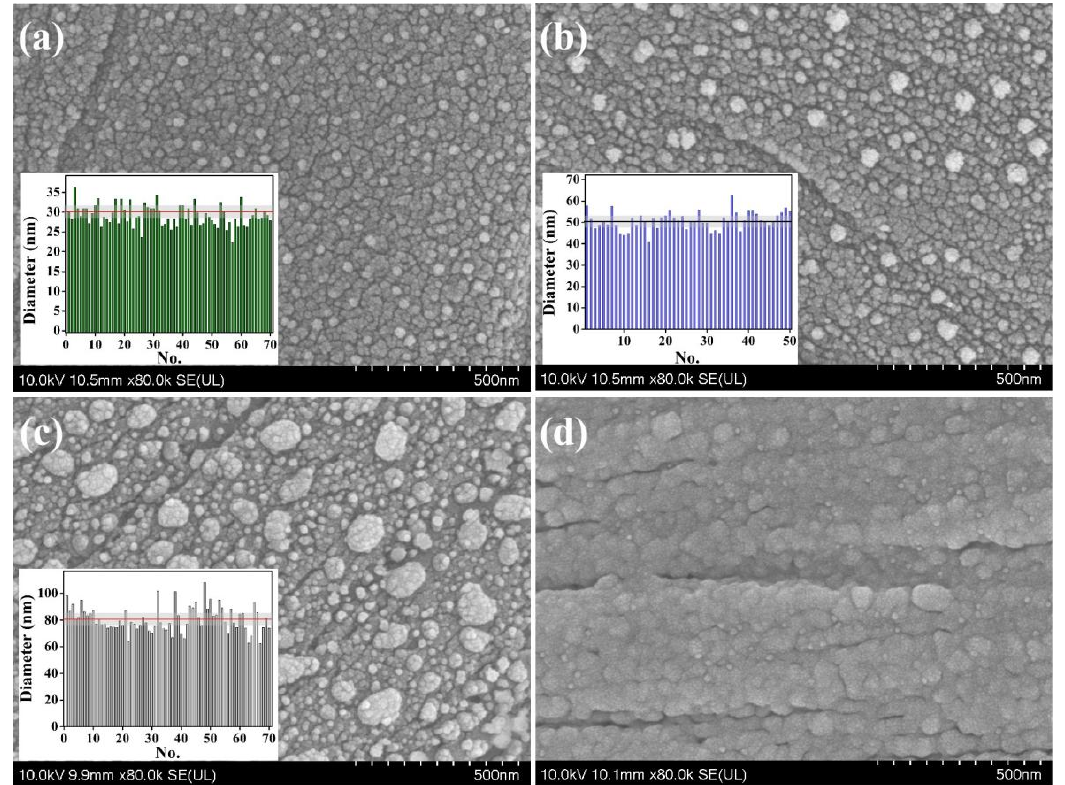
Figure 4. Amplifying FE-SEM images of Ag x -C-fiber substrates prepared with different sputtering times: ( a ) Ag 15 -C-fiber substrate; ( b ) Ag 20 -C-fiber substrate; ( c ) Ag 25 -C-fiber substrate and ( d ) Ag 30 - C-fiber substrate. The illustrations were the histograms of size distribution in the corresponding FE- SEM images.